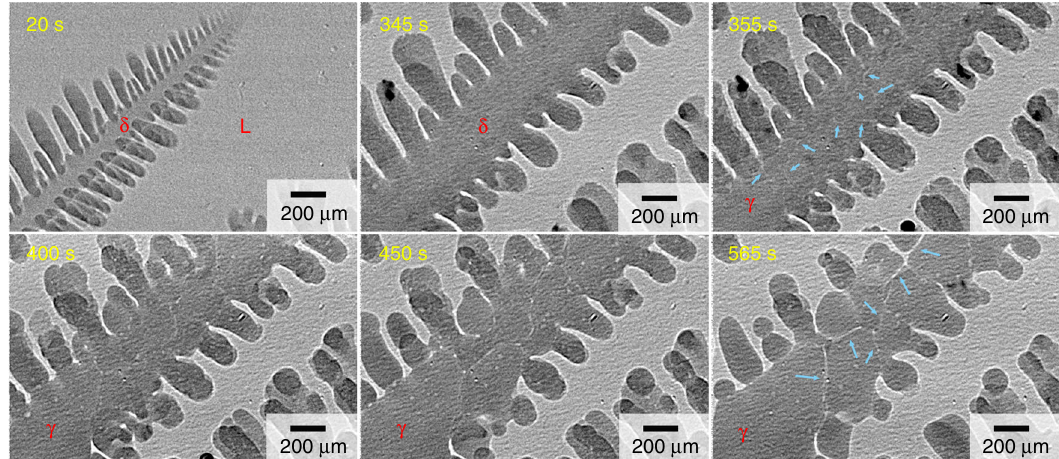
Fig. 1 Fragmentation of γ grains induced by a massive-like δ – γ transformation in 0.45 C steel. The melted specimen was initially cooled at 0.17 K s − 1 and held at 20 K below the peritectic temperature after 152 s. A δ dendrite arm grew from the bottom-left corner to the top. The massive-like δ – γ transformation occurred at 346 s. Blue arrows indicate the liquid fi lm that was produced at the γ grain boundary after the massive-like transformation. Liquid fi lms at the γ grain boundaries were thickened after the massive-like transformation. The X-ray energy and exposure time were 21 keV and 50 ms,